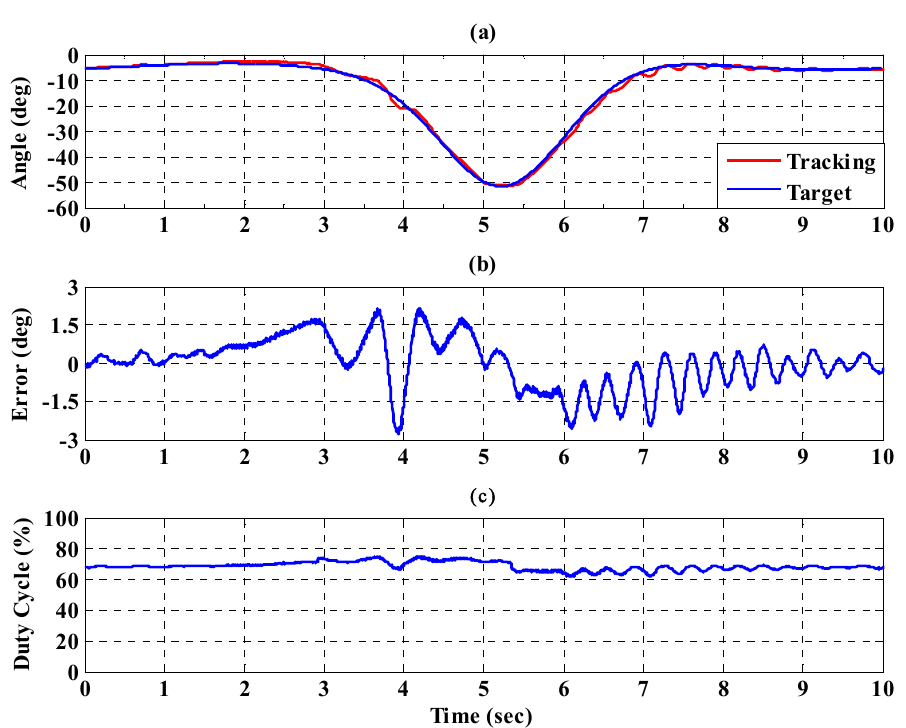
Figure 17. Tracking response of the interval type-2 fuzzy sliding pulse-width modulation controller on the right knee for the PGOS. ( a ) output response; ( b ) tracking error; ( c ) pulse-width modulation control signal.